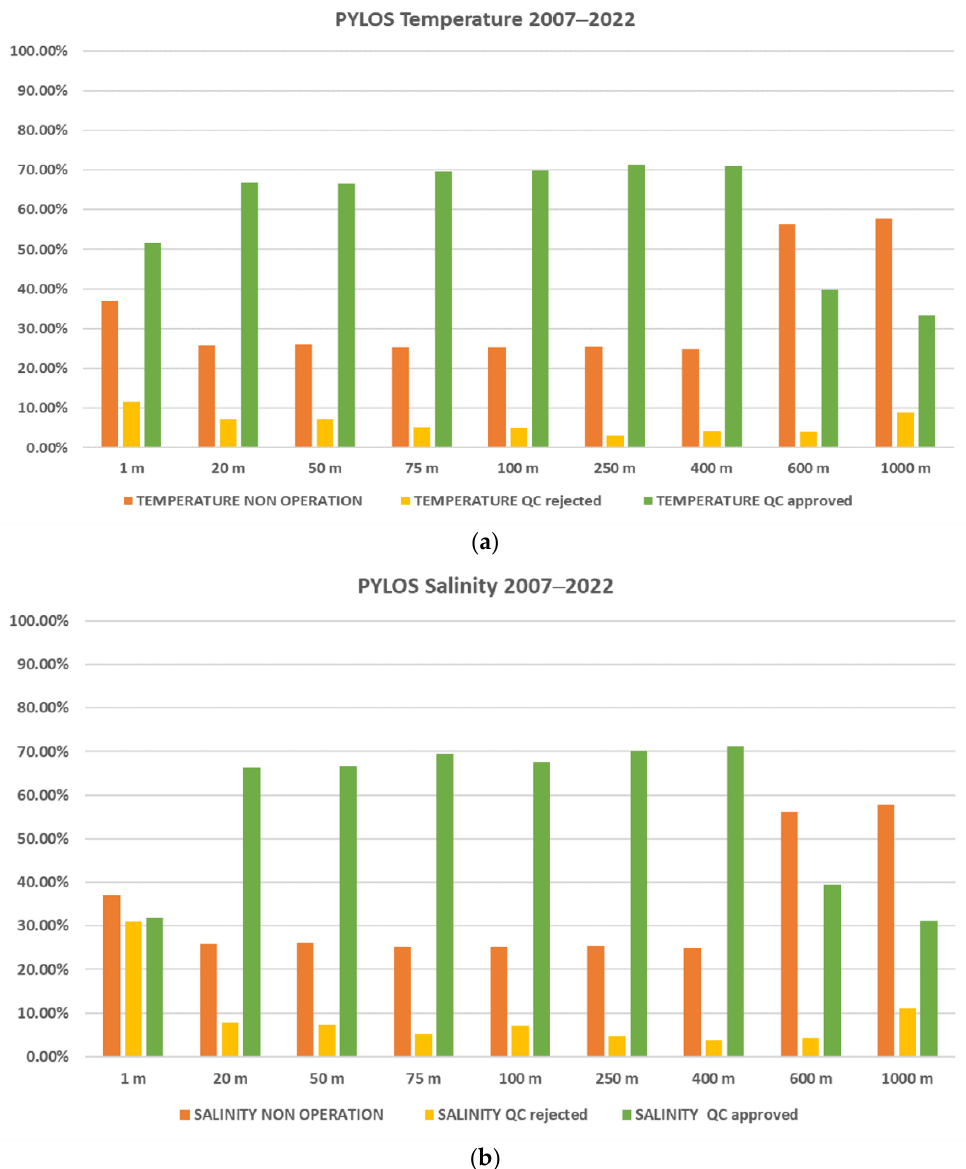
Figure 14. PYLOS percentage of the quality approved data, the rejected data during quality control (QC), as well as the percentage of non-operation periods of the station or sensors for temperature ( a ) and salinity ( b ).